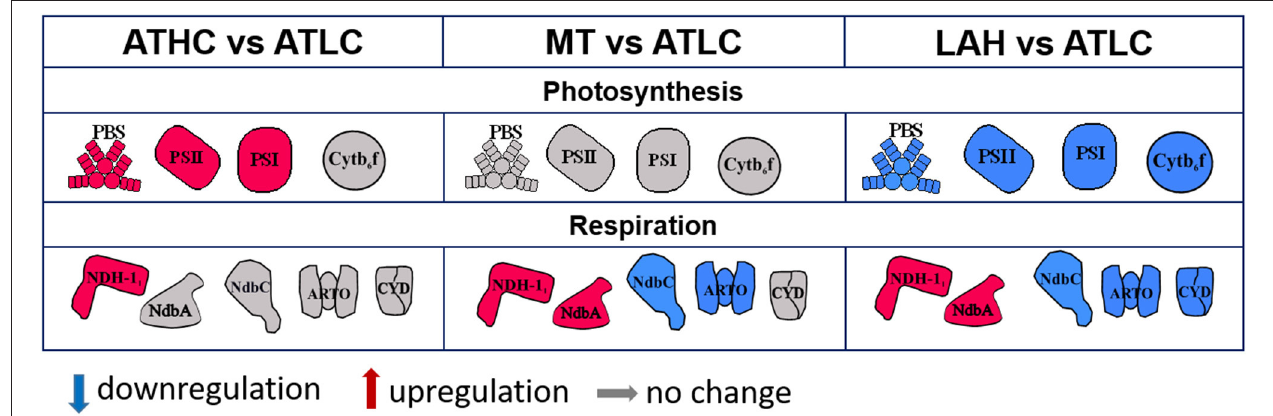
FIGURE 6 | Summary of differentially regulated complexes or proteins from photosynthesis and respiration processes under the ATHC, MT, and LAH conditions compared to the reference ATLC condition. Red color, increase (log 2 FC > 0.58); gray color, no change ( − 0.58 < log 2 FC < 0.58); blue, decrease ( − 0.58 > log 2 FC) in abundance with p <